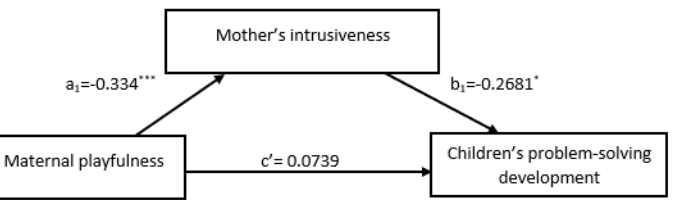
Figure 5. Effect of maternal playfulness on children’s solving-problem development mediated by mother’s intrusiveness. Asterisks (***) indicate the significance effect of maternal playfulness on mother’s intrusiveness ( p < 0.001) (a1), and asterisk (*) indicates the significance effect of mother’s intrusiveness on children’s problem solving ( p < 0.05) (b1).